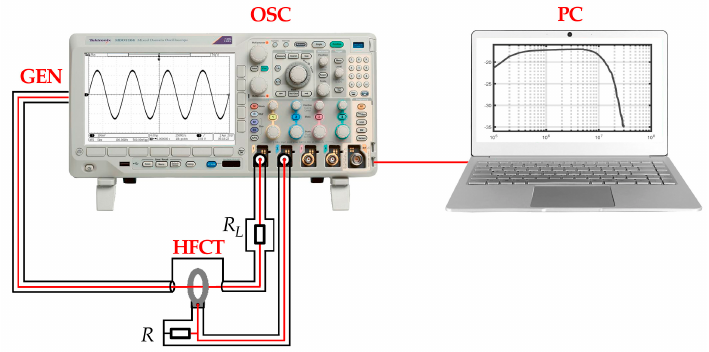
Figure 14. Schematic diagram of the measurement setup for measuring the frequency response of the HFCT sensor; OSC = oscilloscope type Tektronix MDO3104, GEN = built-in arbitrary function generator, PC = computer, HFCT = high-frequency current transformer under test.